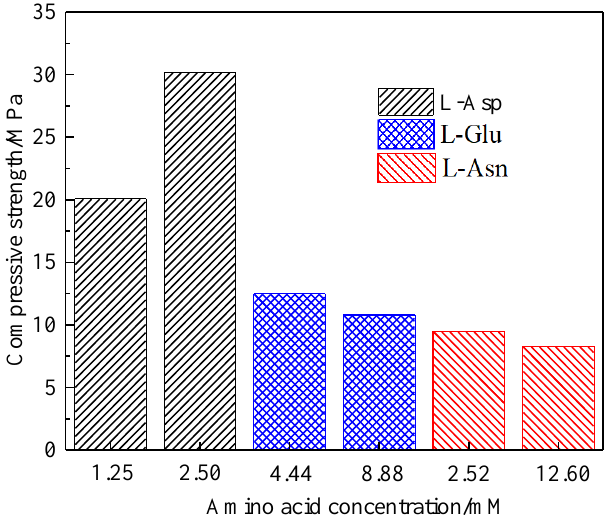
Figure 8. Effect of amino acid concentration on the compressive strength of CaSO 4 ·0.5H 2 O.